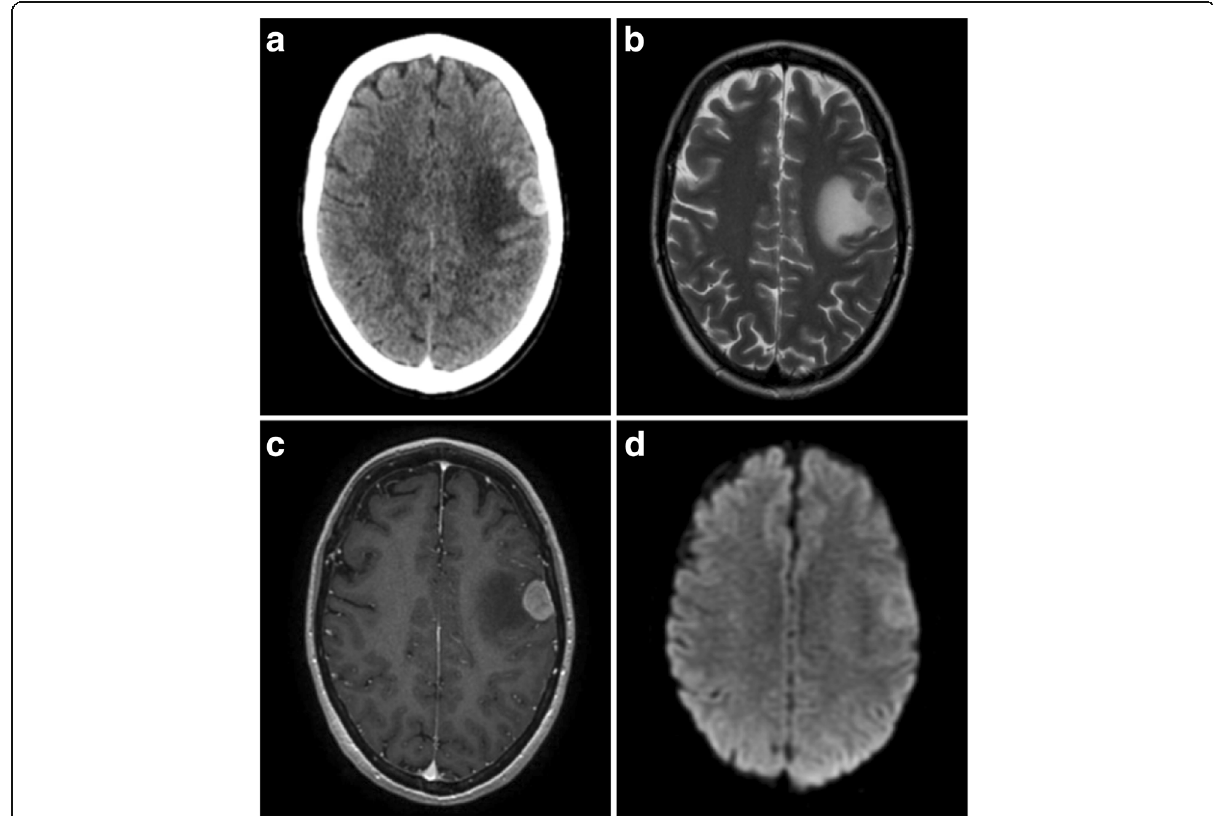
Fig. 4 Breast cancer metastasis. a Post-contrast axial CT showing a strongly enhancing extra-axial lesion with a wide dural base and associated vasogenic oedema. There is no bony hyperostosis or erosion. b T2-weighted axial image of the same lesion which has an indistinct cortical interface suggestive of involvement. c Post-contrast axial T1-weighted MR image of the lesion with some slight heterogeneous but strong enhancement. d Diffusion-weighted imaging demonstrated intermediate restricted diffusion within the